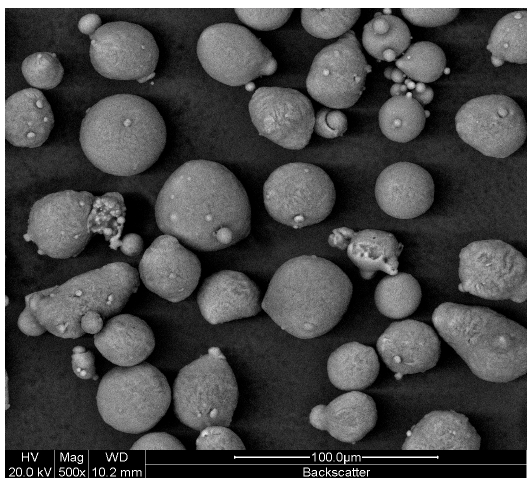
Figure 7. BSE image of med oxygen Al powder.